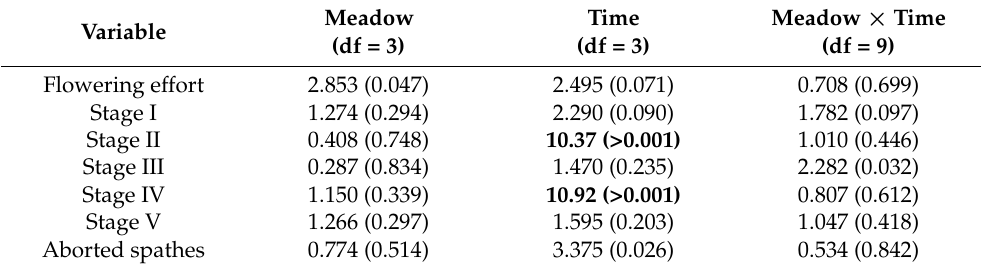
Table 3. Results obtained in the two-way ANOVA analyses for FE and stages of sexual reproduction. Results are expressed as F -values and associated p -values (in parenthesis). Significant results are in bold. The significance level in all tests was α = 0.01.